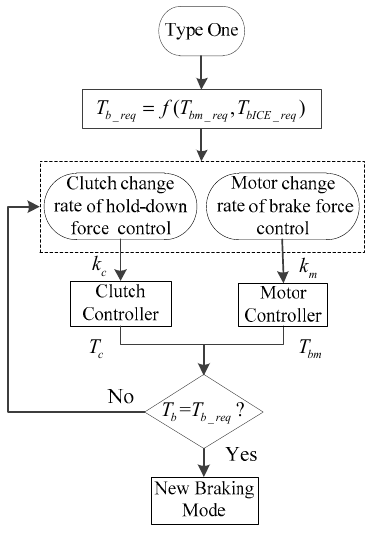
Figure 8. Flow control chart of the first type mode-switch.